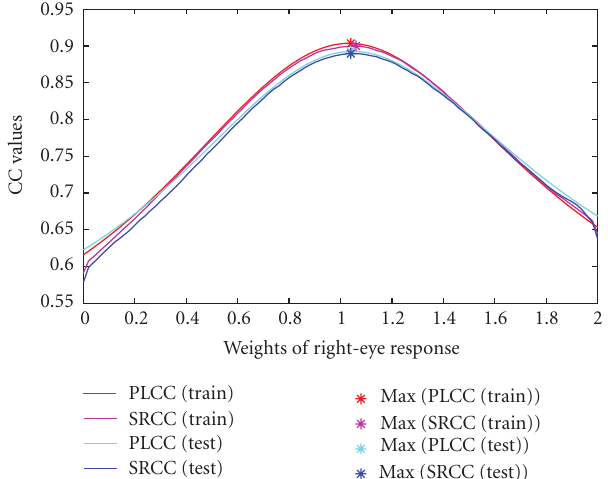
Figure 3: PLCC and SRCC values (given in Section 6) based on di ff erent weights of right-eye response (the summation of both weights is 2) and their maximum values and corresponding weight values (“ ∗ ”). Weights of right-eye response are tested from 0 to 2, and the concealed part has the lower value than the revealed